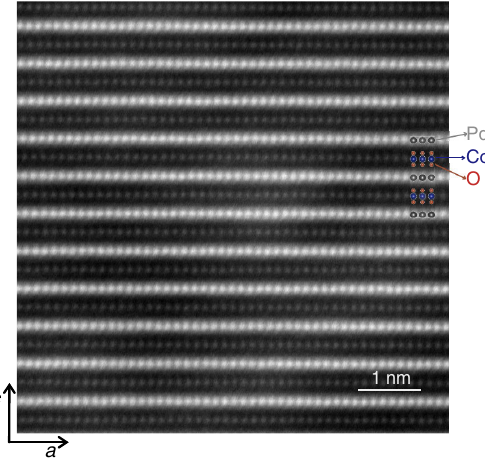
FIG. 3. STEM image of a pristine PdCoO 2 sample taken at high magnification resolving Pd and Co atomic sites using high-angle annular dark field (HAADF STEM)